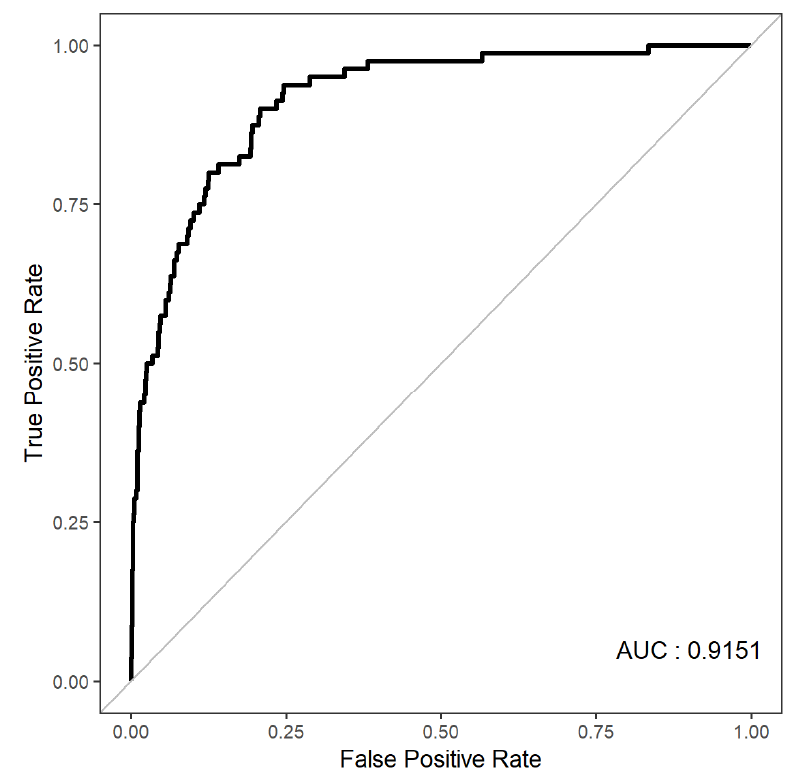
Figure 3. The AUC of the developed nomogram for predicting depression in older adults.AUC:the area under the curve